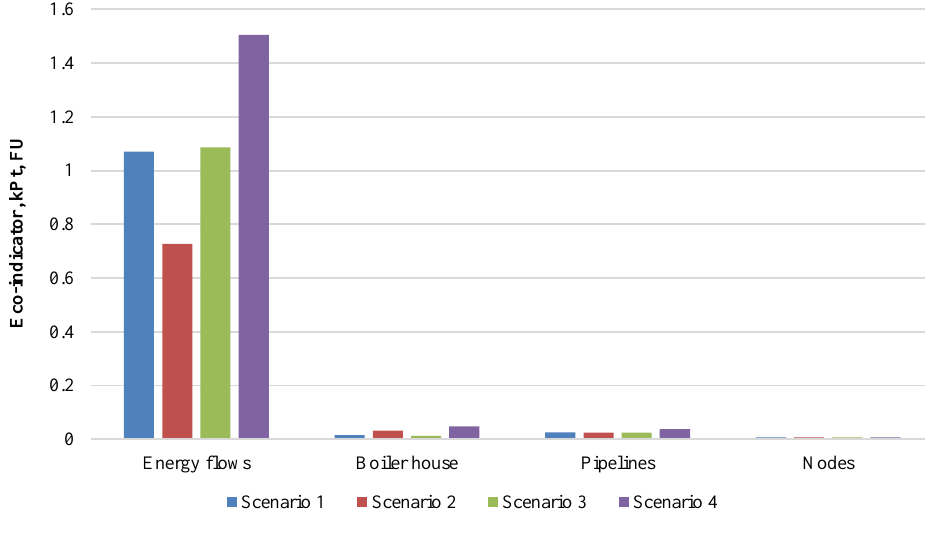
Fig. 2. Impact assessment score per part of